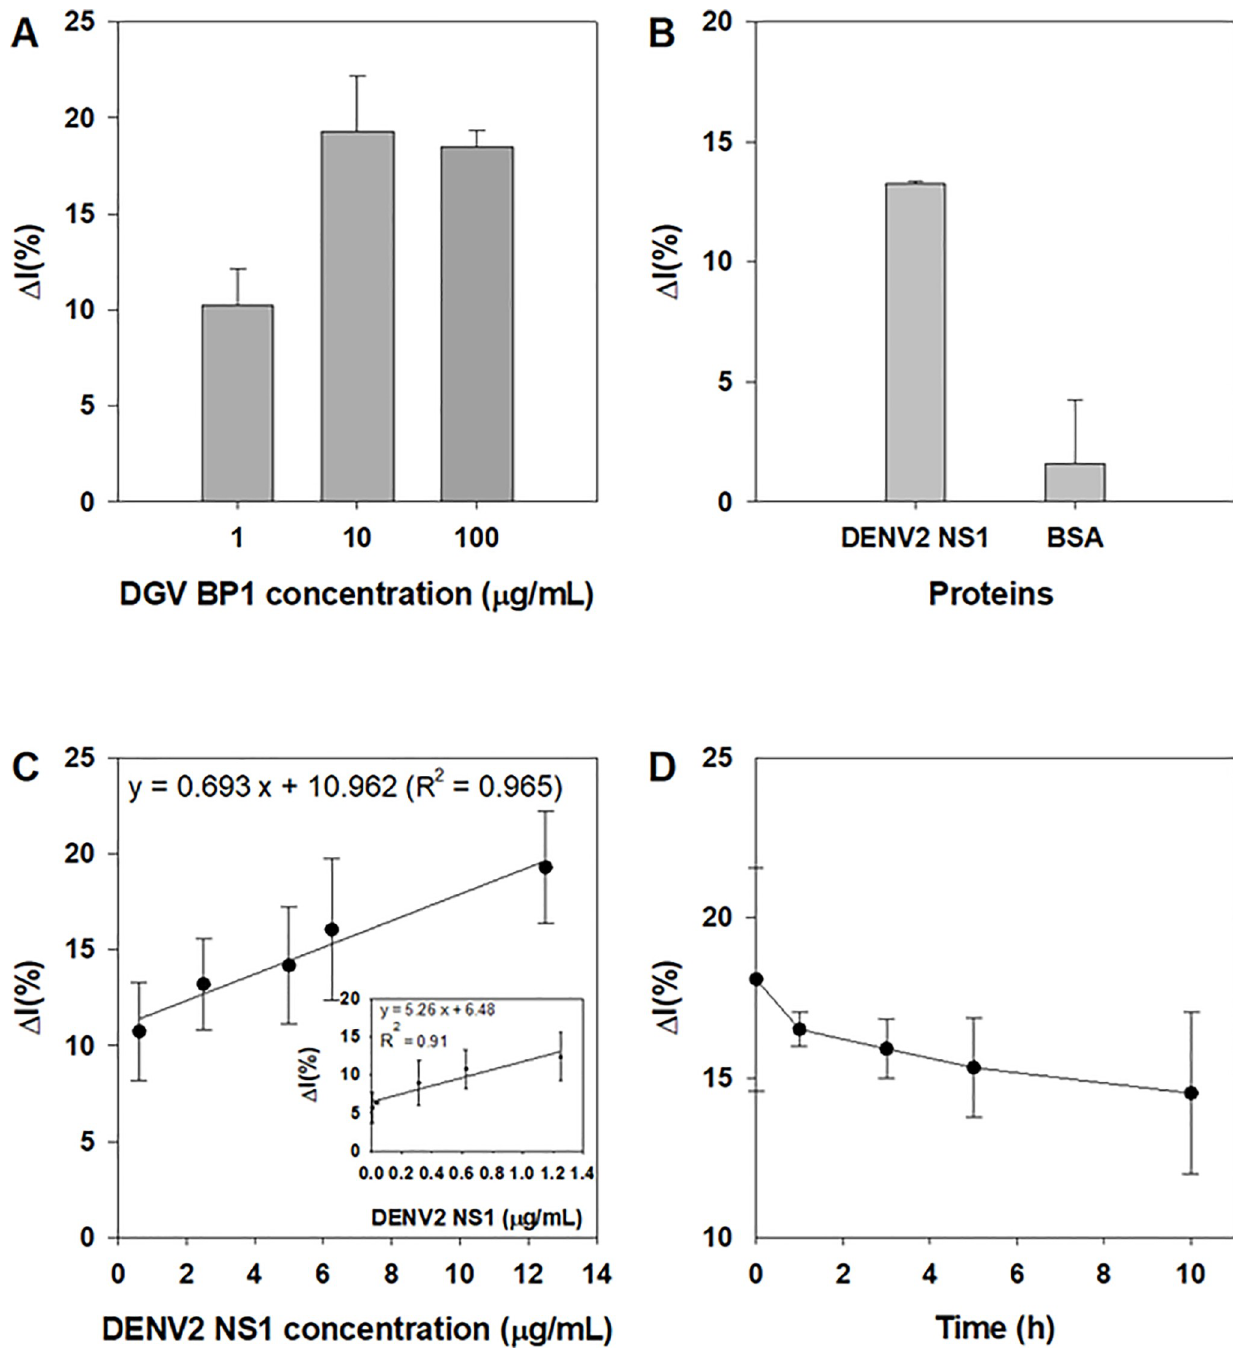
Fig 4. Relative binding affinity. (A) Effect of peptide concentrations. The current change at varying concentrations of DGV BP peptides (from 1 to 100 μ g/mL) on a gold electrode layer was measured before and after the addition of pure dengue virus (DENV) type 2 nonstructural 1 (NS1) proteins (denoted DENV2 NS1, 12.5 μ g/mL). (B) Relative current change on the binding interaction. (C) Linear correlation of the sensor with different NS1 protein concentrations, measured by square wave voltammetry. Inset shows relationship between relative I (%) with lower concentration of NS1 ranging from 0 to 1.4 μ g/mL. (D) Stability test of affinity peptide-decorated sensor.